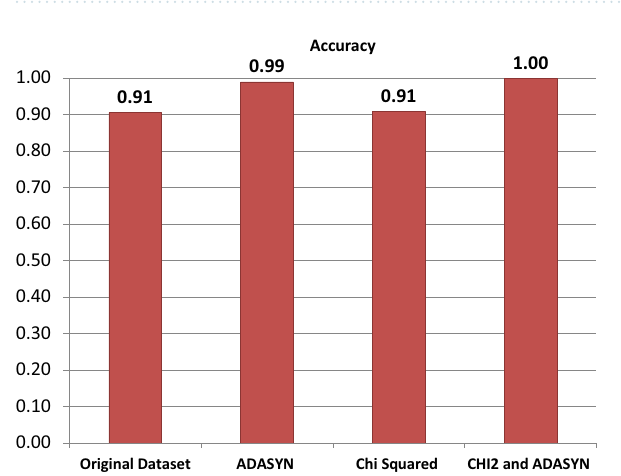
Figure 7. Results of the models’ performance after applying each technique.